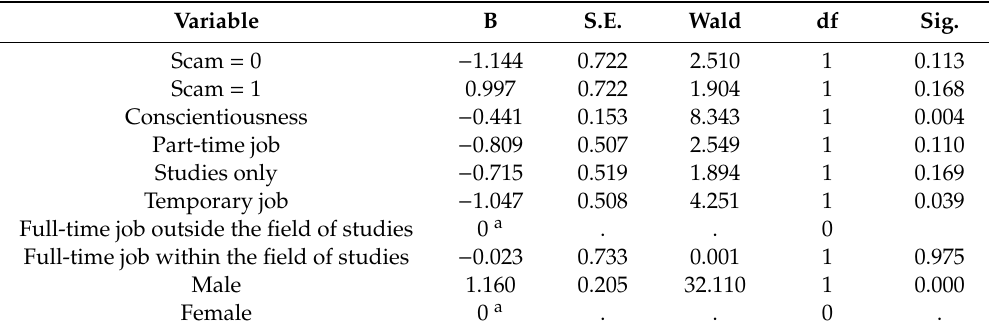
Table 8. Streamlined Model 4—Scam: ordinal logistic